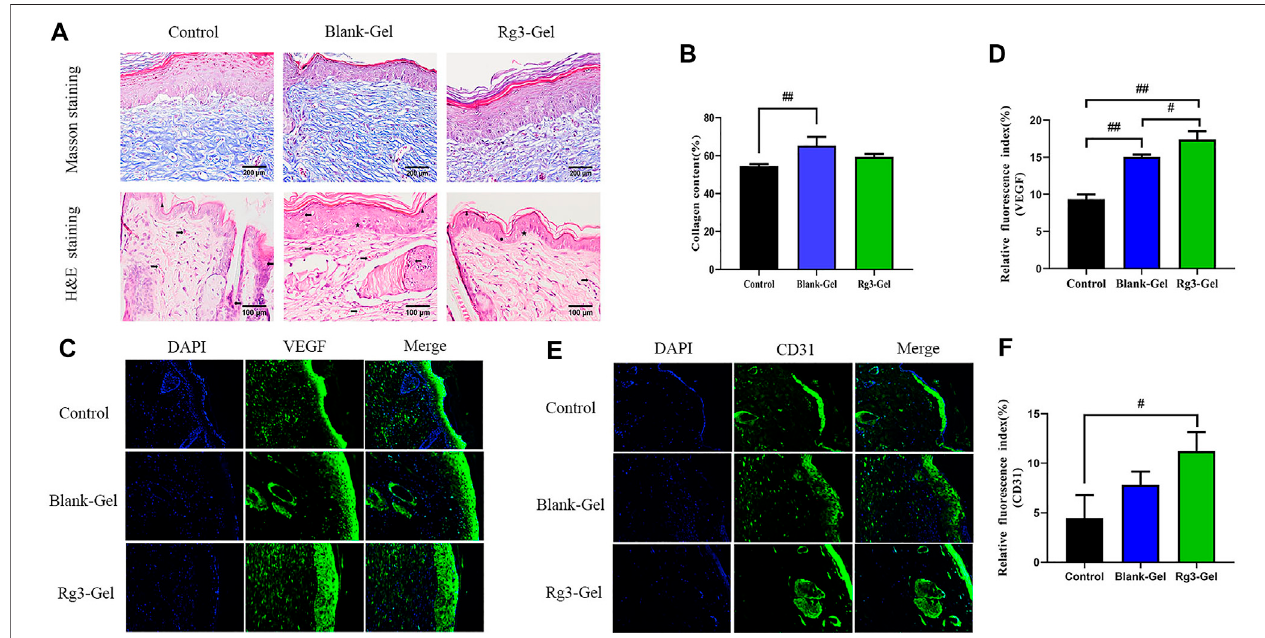
FIGURE 5 | Histological and vascularization assessment after different treatments. (A) Masson trichrome staining and H&E histological staining of wounded skin tissue sections in different groups at 16 days post-wounding (×400 magni fi cation and scale bar 200,100 μ m). The right arrow represents capillary vessels, while the left arrows represent in fl ammatory cells. The triangle, star, and circle represent epidermis , hair follicles and glands, respectively. (B) Proportion of collagen fi bers in the regenerative tissues ( n = 3). (C,D) VEGF immuno fl uorescence staining images and quantitative analysis in wound areas of different groups. (E,F) CD31 immuno fl uorescence staining images and quantitative analysis in wound areas of different groups (n = 3).